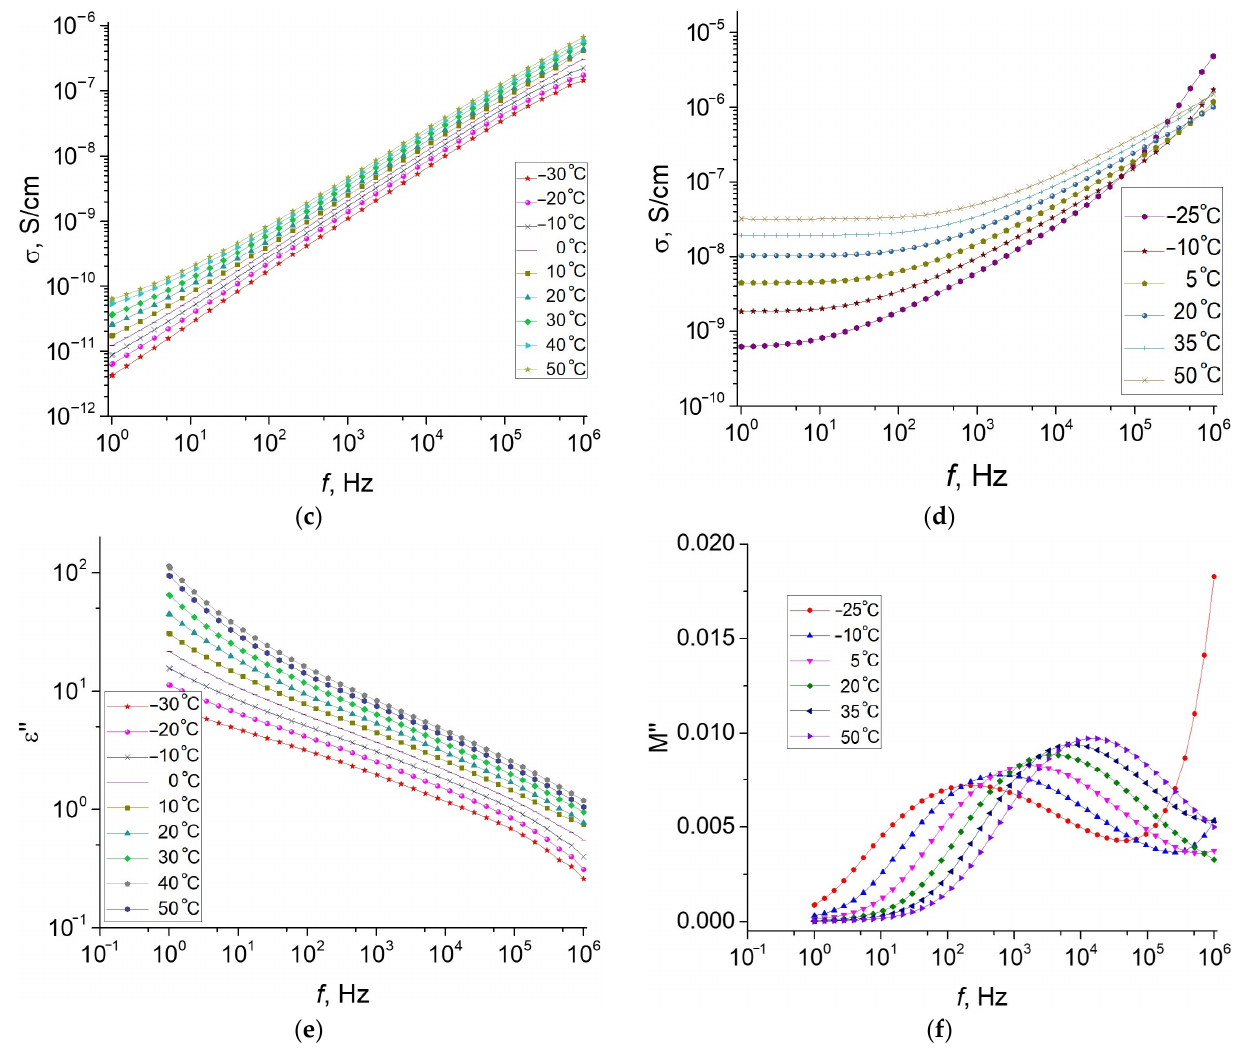
Figure 3. Frequency dependence of ( a,b ) the dielectric constant and ( c,d ) conductivity as well as ( e ) the dielectric losses and ( f ) the modulus, measured at various temperatures for ( a,c,e ) the original MAE–Fe and ( b,d,f ) magnetized MAE–Fe–m samples.